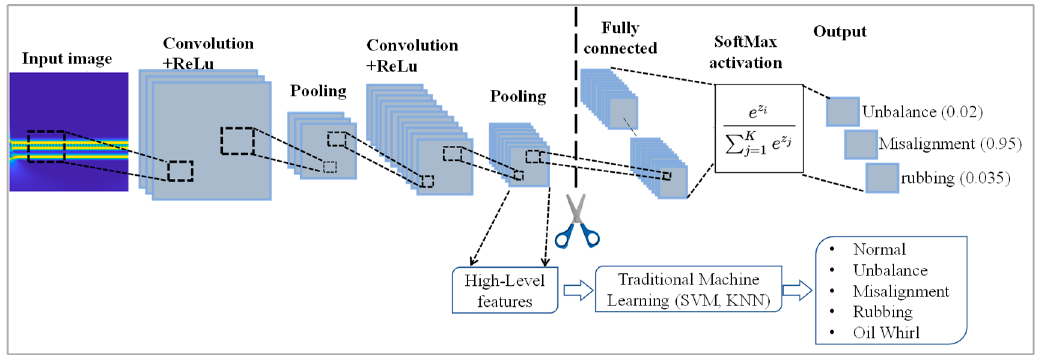
Figure 11. Autonomous feature extraction via a pretrained deep learning model.